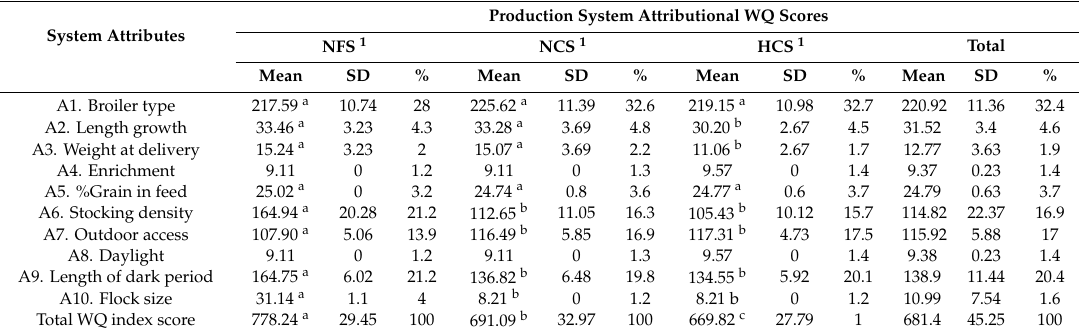
Table 3. Mean attributional WQ scores and WQ index scores per system